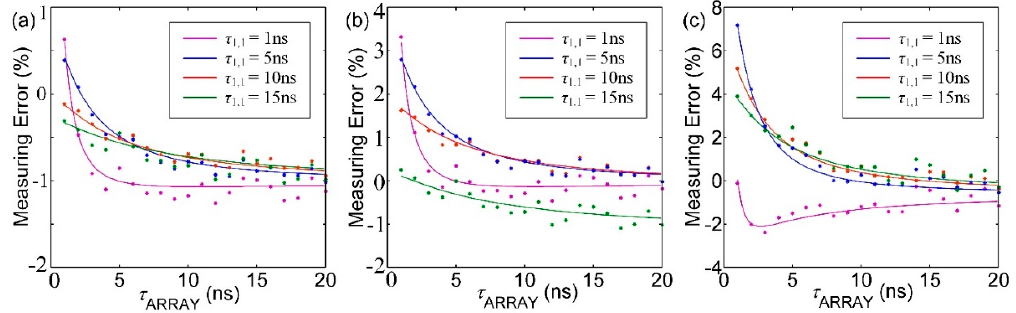
Figure 9. The relationship between measuring errors and τ ARRAY while using ( a ) MLE; ( b ) CMM; ( c ) LSM to estimate lifetimes.